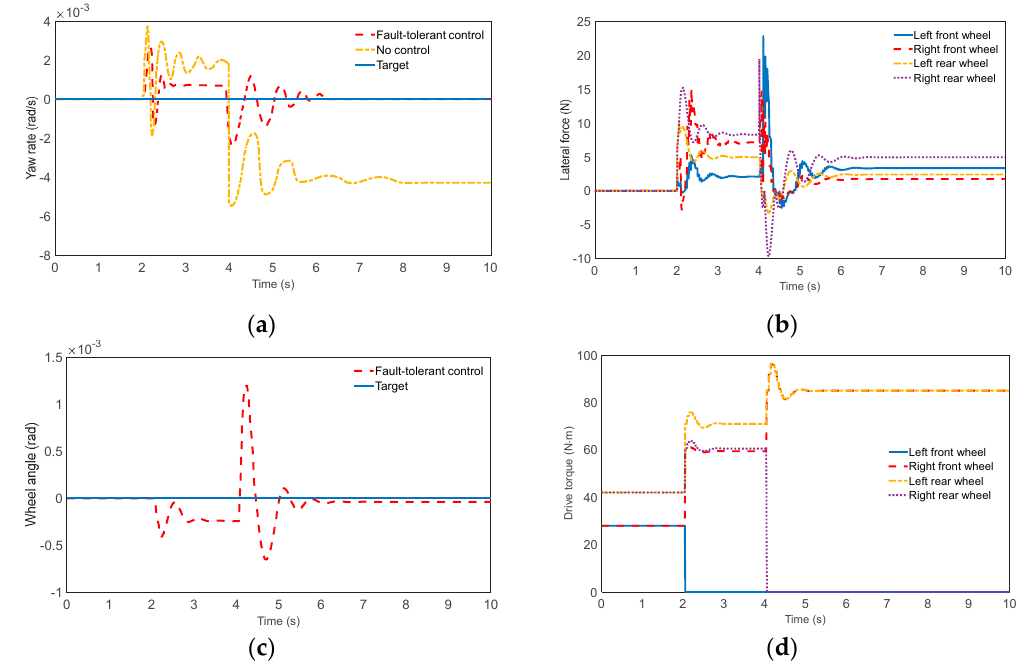
Figure 5. Results of two failed wheels on a straight road: ( a ) Yaw rate; ( b ) Lateral force; ( c ) Wheel angle; ( d ) Drive torque.